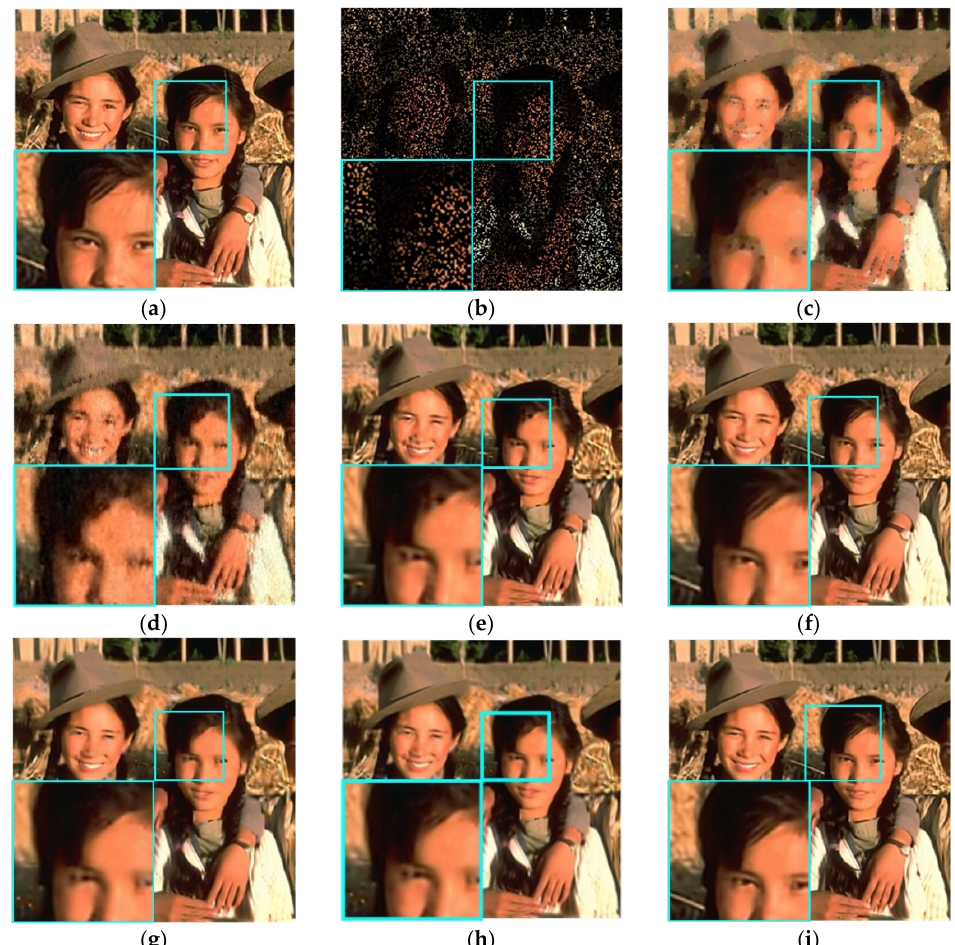
Figure 4. The restoration result of girl with pixel missing rate of 80%. ( a ) Girl, ( b ) girl with pixels miss- ing rate 80%, ( c ) SALSA [38] (PSNR = 23.79), ( d ) BPFA [4] (PSNR = 22.47), ( e ) GSR [13] (PSNR = 25.50), ( f ) MAR-LOW [41] (PSNR = 29.21), ( g ) JPG-SR [14] (PSNR = 25.55), ( h ) GSRC-NLP [27] (PSNR = 26.02), ( i ) our model (PSNR =